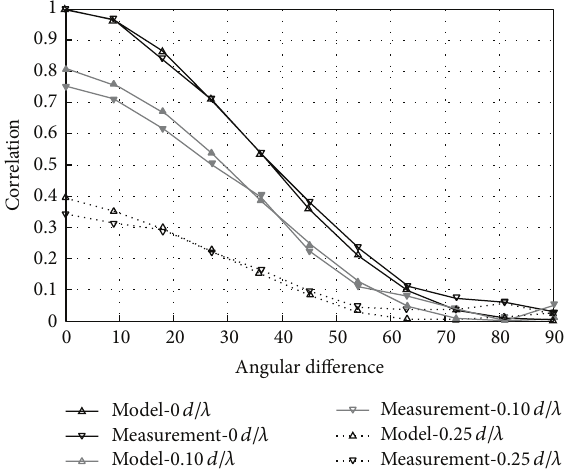
Figure 6: Simulated and measured correlation versus angular difference with distance as a